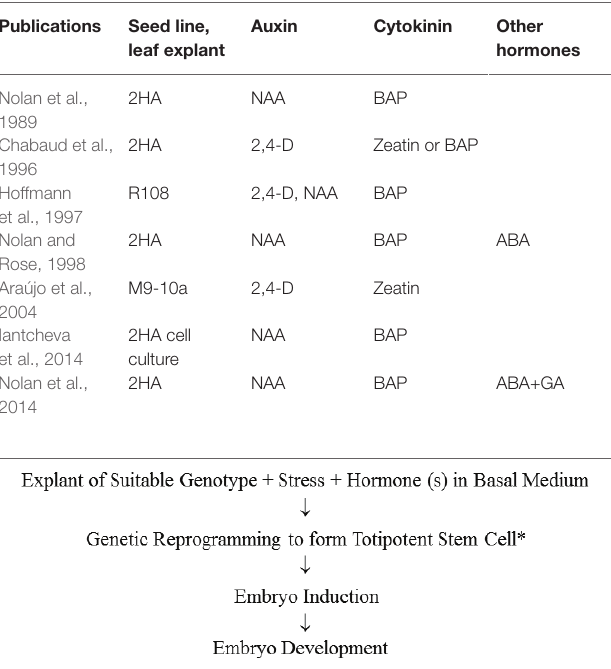
TABLE 1 | Exogenous hormones and seed lines used for somatic